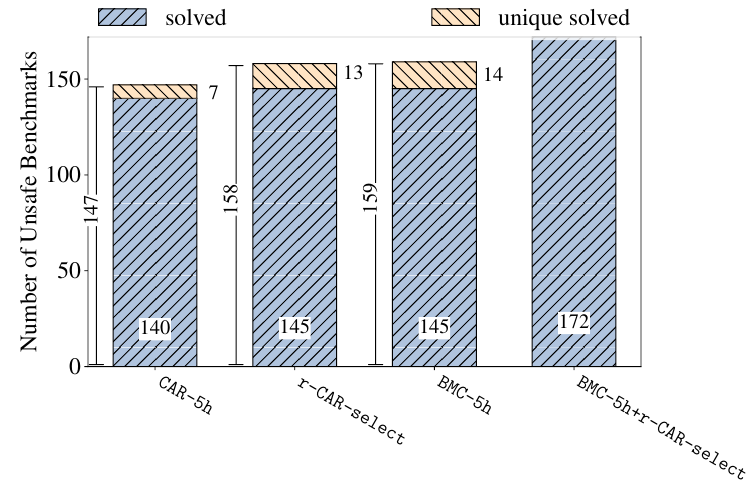
Figure 4. Comparison of the number of